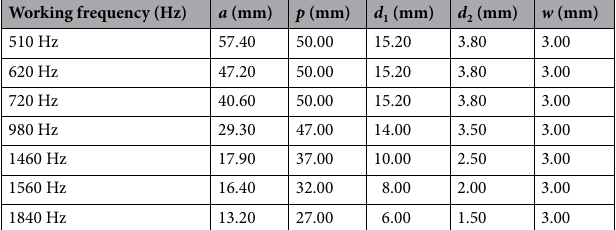
Table 2. The parameters of the silencer elements in the